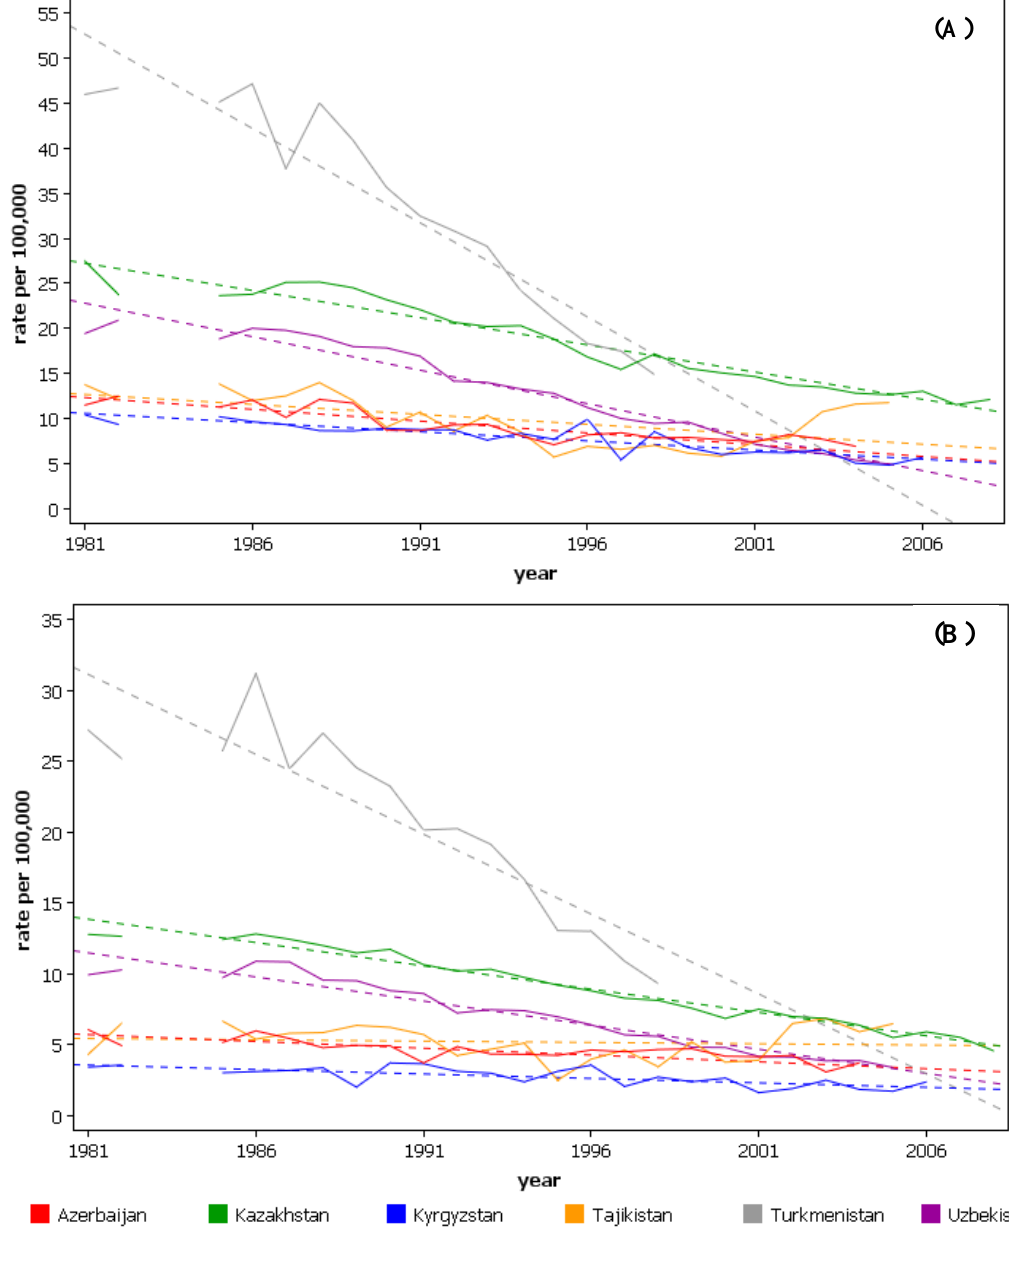
Figure 2. Mortality trends from esophageal cancer for the Central Asian Republics, age- standardized rates (world). ( A ) males; ( B ) females. (From the WHO mortality database, International Agency for Research on